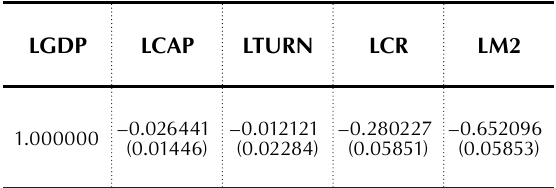
Table 4. The co-integration equation results